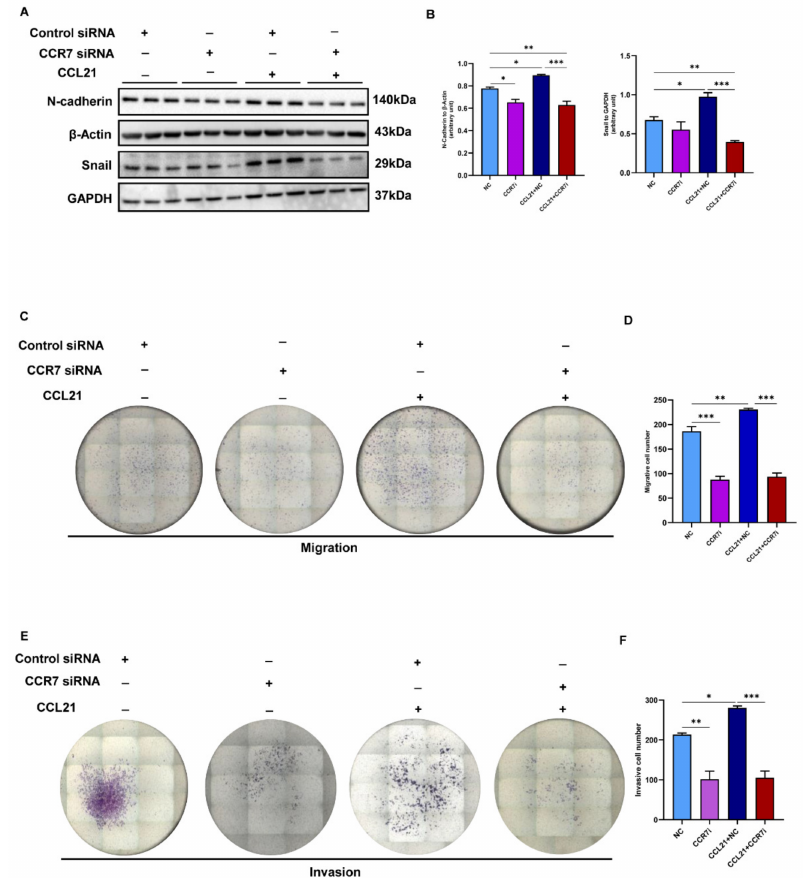
Figure 6. Knockdown of CCR7 inhibited trophoblast cells EMT, migration, and invasion. The HTR8/SVneo cells were transfected with small interfering CCR7. After 48 h transfection, the cells were treated with 500 ng/mL of rhCCL21 for 48 h in a medium containing 0.5% FBS. ( A ) Western blotting analysis of the expression of EMT markers in CCR7-knocked-down cells treated with rhCCL21 or not (Supplementary File S1). ( B ) Statistical analysis of protein densitometry quantification in Figure 7A. ( C , D ) Scratch wound-healing assay and quantitation were performed to determine trophoblast cell migration ability. ( E , F ) Matrigel invasion assay and quantitation were conducted to investigate trophoblast invasiveness ability; * p < 0.05, ** p < 0.01, *** p <